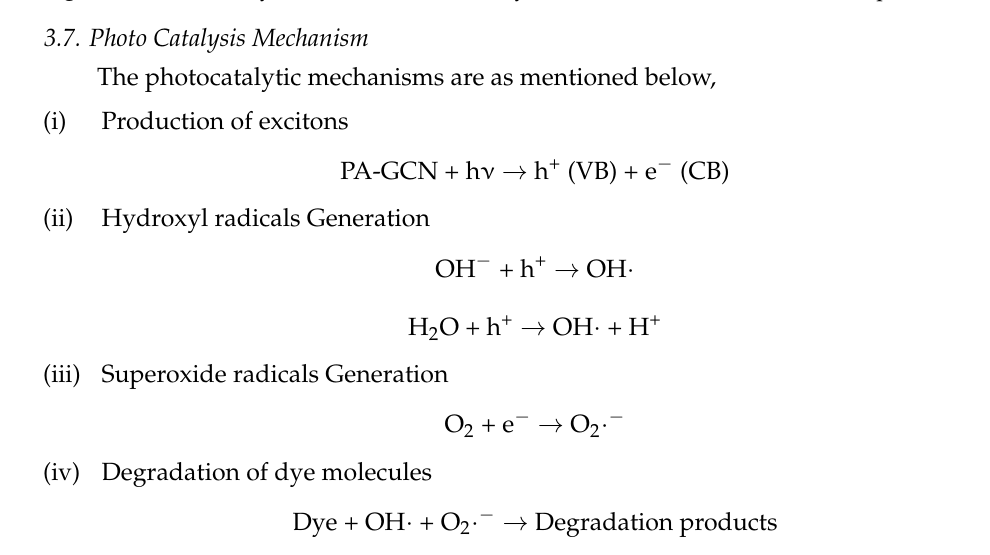
Figure 13. HPLC analysis of the ( a ) FG ( b ) RB dye solution of before and after the experiment.